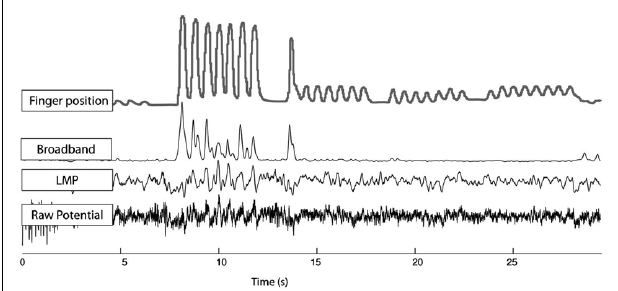
FIGURE 26 | (Data Set 4). Time courses of finger flexion, broadband, LMP, and the raw electric potential.The LMP (Schalk et al., 2007; Kubanek et al., 2009) has been shown to hold information about different motor behaviors. Spectrally broadband change, corresponding to 1/f type change in the electric potential power spectrum (Miller et al., 2009a,b), can be captured as another powerful correlate of motor behavior. By synthesizing different features, more powerful brain-computer interfacing algorithms may be